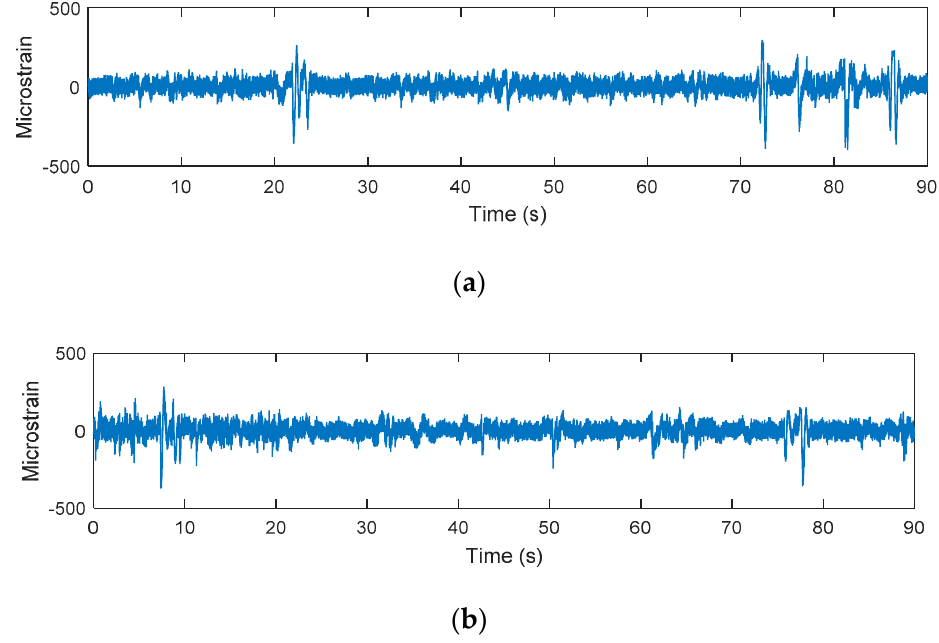
Figure 13. Measured strain signals: ( a ) Rural A, ( b ) Rural B.